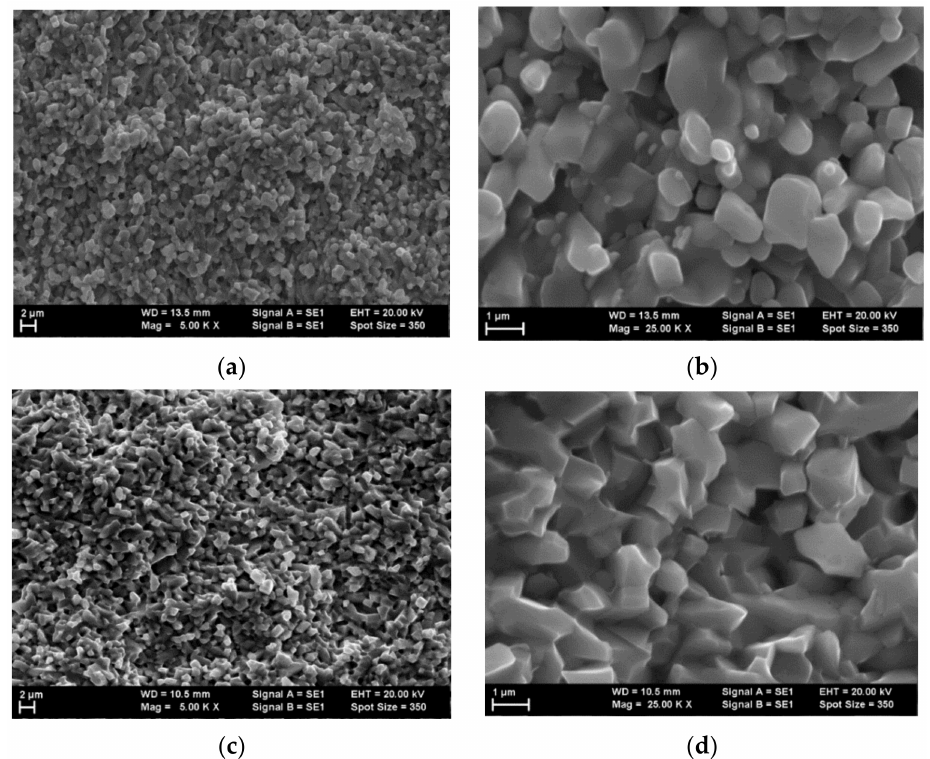
Figure 3. SEM micrographs of the ZST samples sintered at ( a , b ) 1150 ◦ C and ( c , d ) 1200 ◦ C. The images were recorded at ( a , c ) 5000 × magnification and ( b , d ) 25,000 × magnification using an accelerating voltage (EHT) of 20 kV.